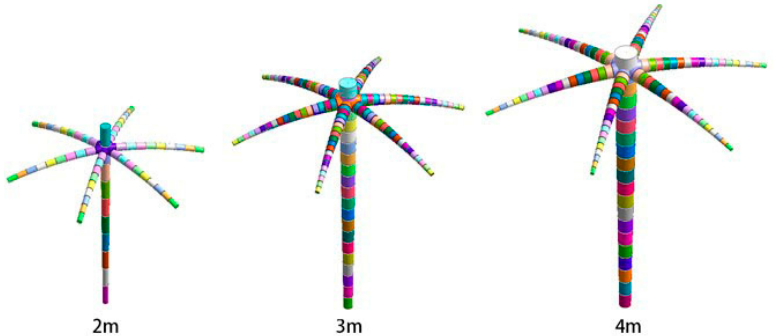
Figure 3. 3D root system model of living elm stump with different tap root lengths.